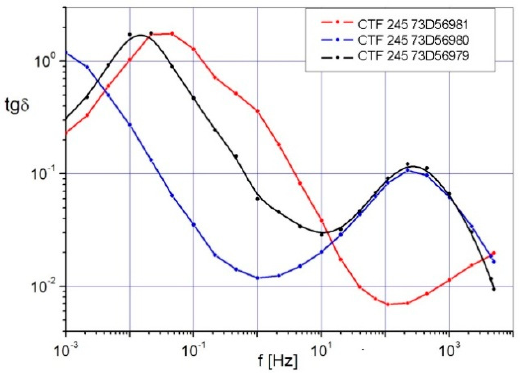
Figure 12. Frequency characteristics of the tg δ coefficient of CTF 245 kV bushings after 25 years of service.